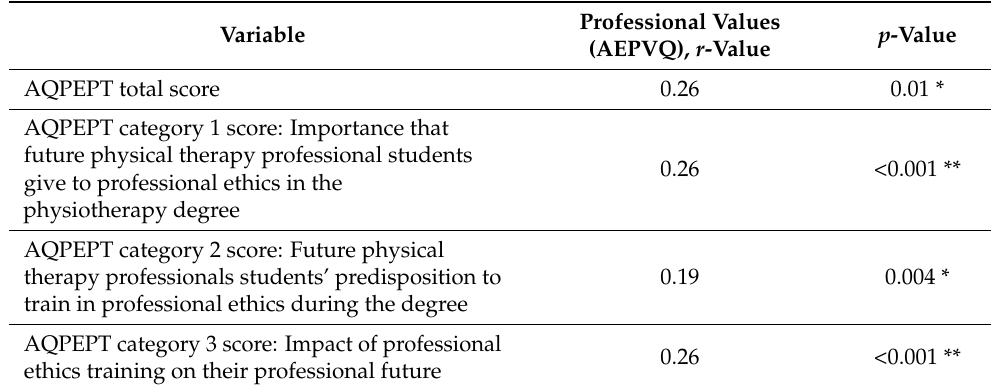
Table 2. Correlation between attitudes towards professional ethics and professional